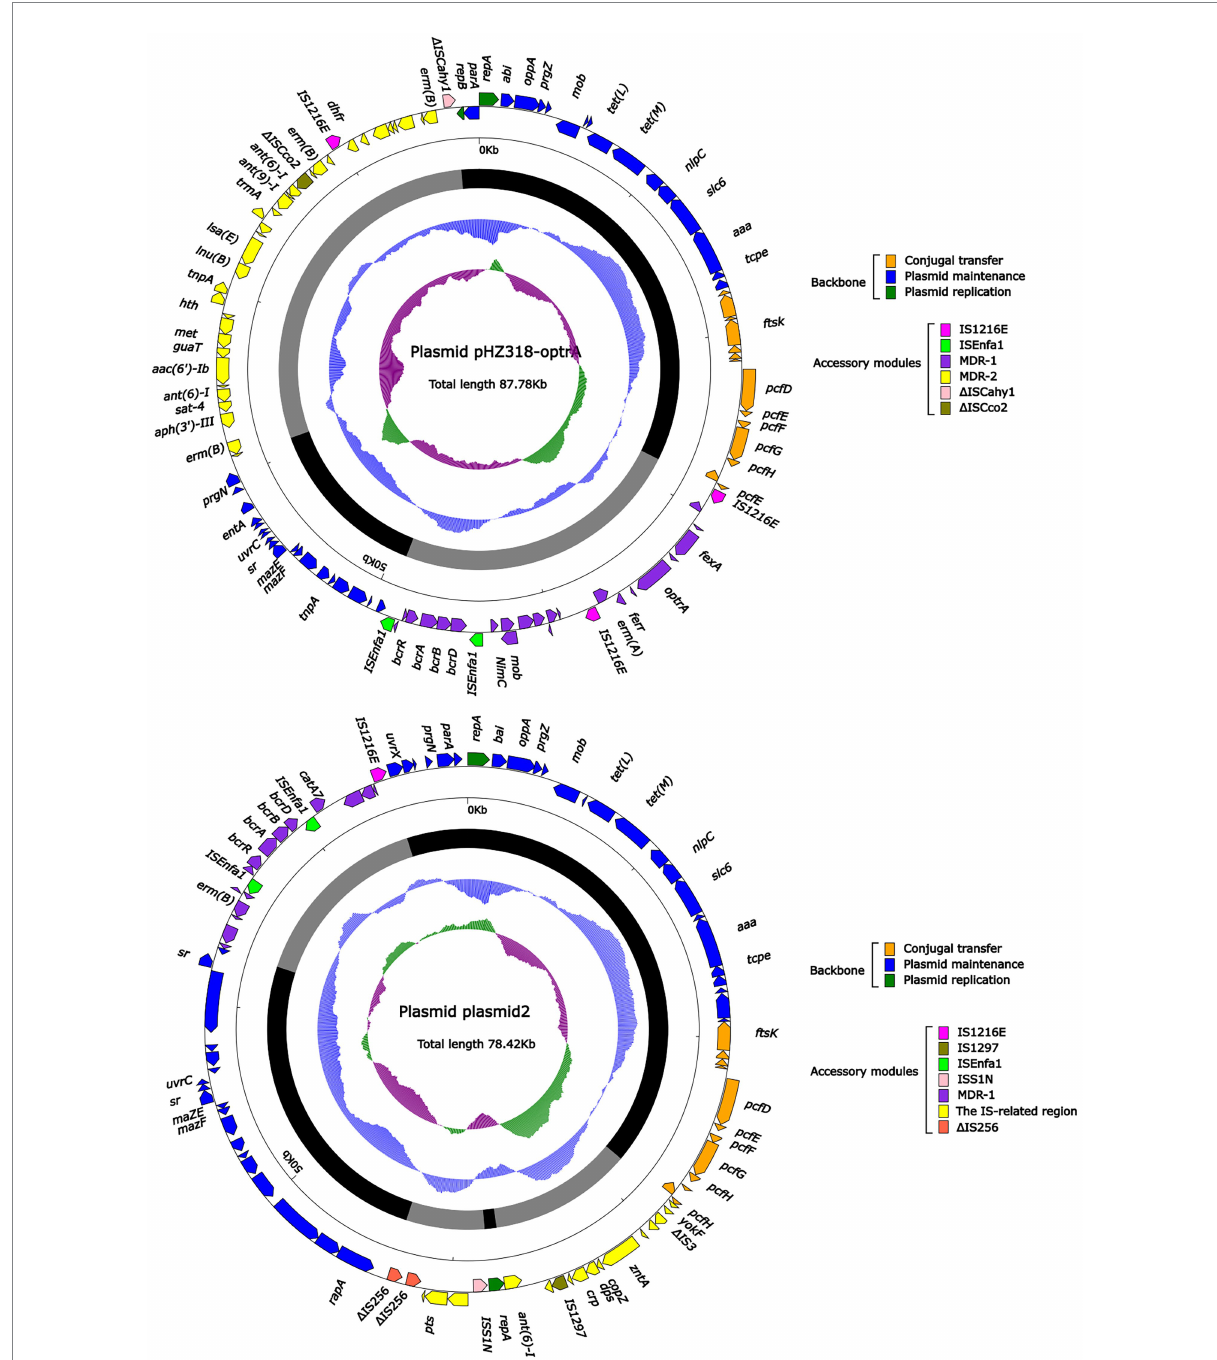
FIGURE 4 The complete sequence diagram of pHZ318-optrA and plasmid2. In the figure, the innermost ring represents (G − C)/(G + C); the blue ring indicates GC content, and the outward depression indicates that the GC content is higher than the mean value. Black area in the outer circle represents the backbone area and gray area represents the accessory modules. The outermost circle shows the distribution of genes represented by colored arrows in the